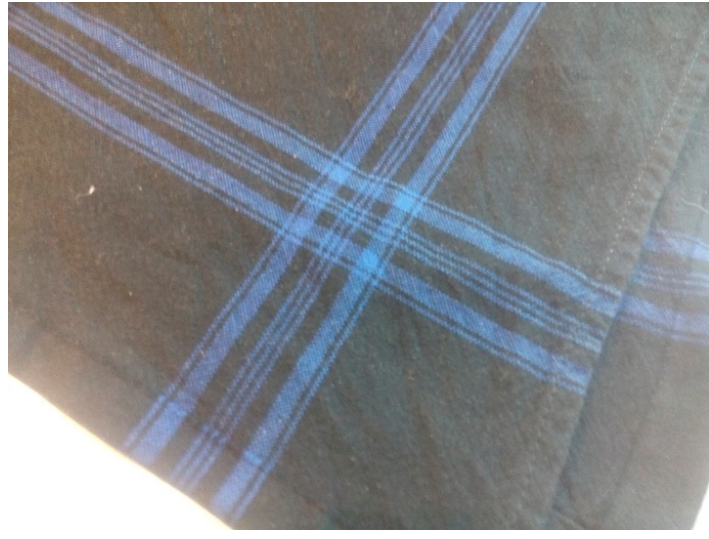
Figure 5. The körtti scarf today. Photograph: author.